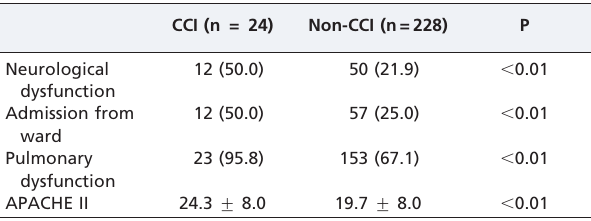
Table 2 - Predictors of evolution to chronic critical illness.